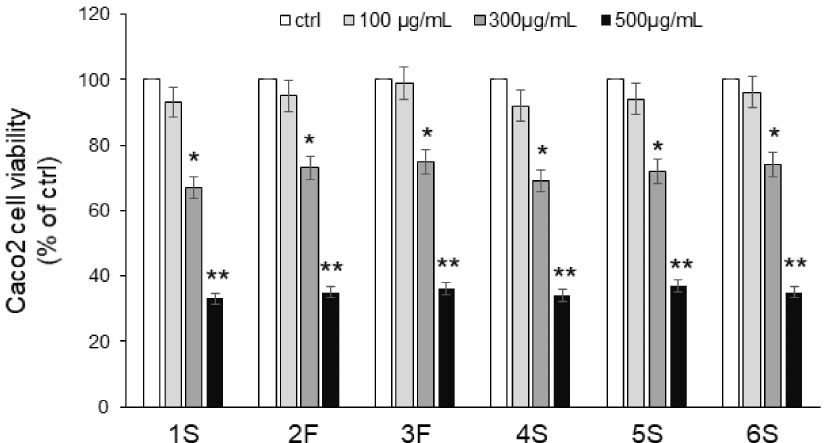
Figure 5. Effects of chamomile extracts on the viability of human epithelial Caco2 cells. Caco2 cells were incubated in the absence (ctrl) or in the presence of increasing concentrations (100–500 µ g/mL) of chamomile extracts. After 24 h incubation, cells were harvested, and viability was assessed by MTT assay. Values are reported as percentage of control (ctrl) set to 100%. Data represent the mean ± SEM of at least three independent experiments, each performed in quintuplicate. * p < 0.05 and ** p < 0.001 vs.